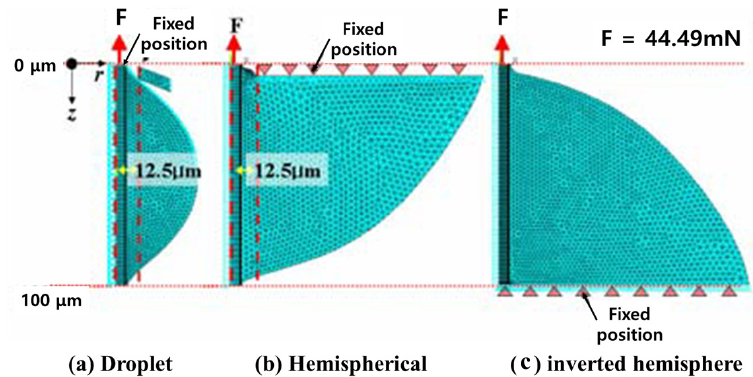
Figure 6. Simulation behavior according to droplet according to load.